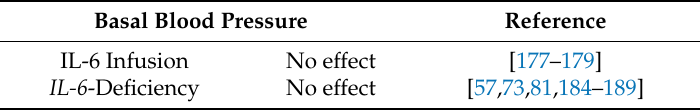
Table 2. Effect of IL-6 infusion or IL-6 -deficiency on Basal Blood